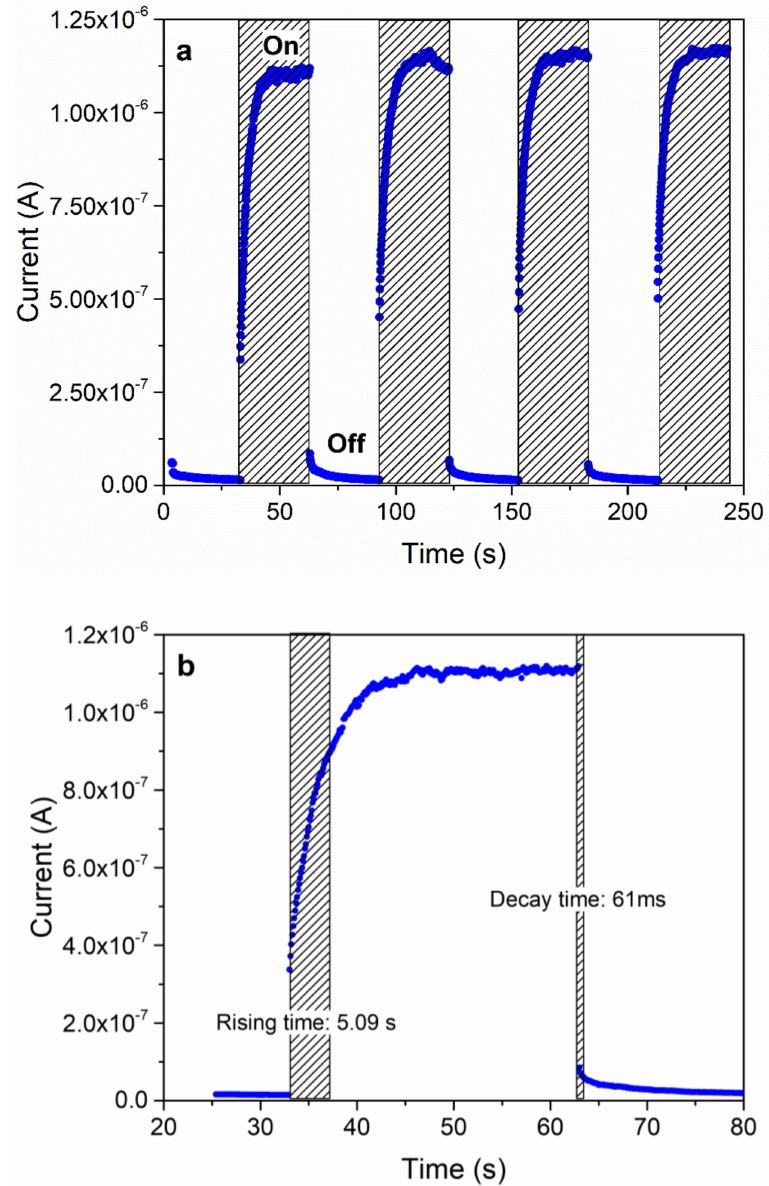
Figure 5. ( a ) I–t curve of MSM PPDs measured under zero applied bias and using a white LED light. ( b ) Estimation of the rise time and decay time of MSM PPDs from the I–t curve shown in ( a